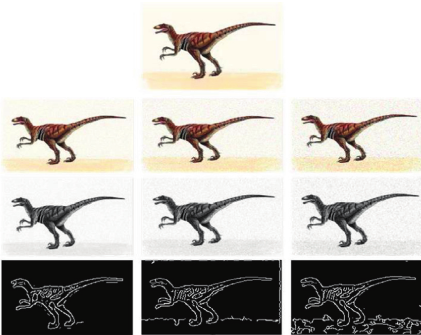
Figure 5: Extraction of edges in presence of Gaussian Noise. Firstly, Gaussian noise of 5, 10, and 15 (%) is inserted. Secondly, conversion of RGB to gray scale is done; then, NRLGO is applied to detect the